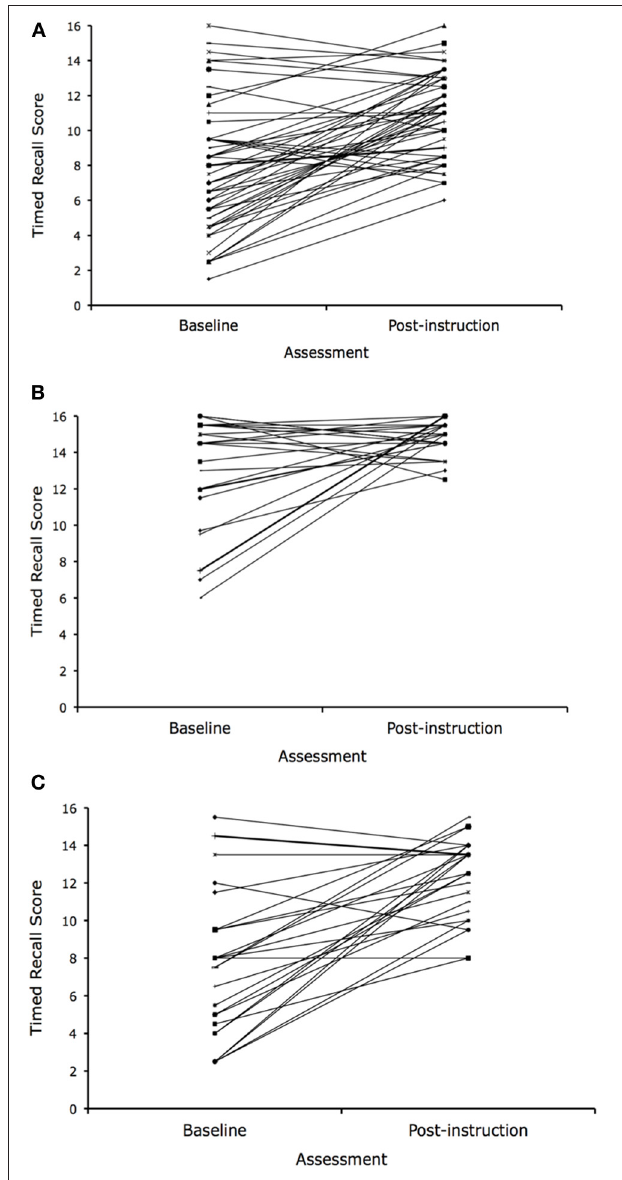
FIGURE 5 | Individual baseline performance and gains from instruction. Performance at baseline and post-instruction assessments for each individual in the group of children (A) , younger adults (B) , and older adults (C) . The scores at baseline and post-instruction assessments are unit-weighted composites of the two lists indicating performance at each assessment, respectively. To plot all scores on the positive axis, a constant of 10 has been added to all